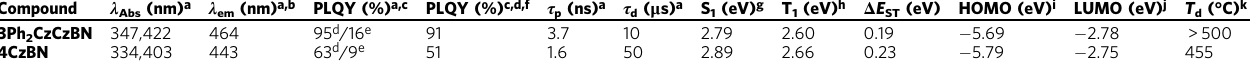
) for the delayed a